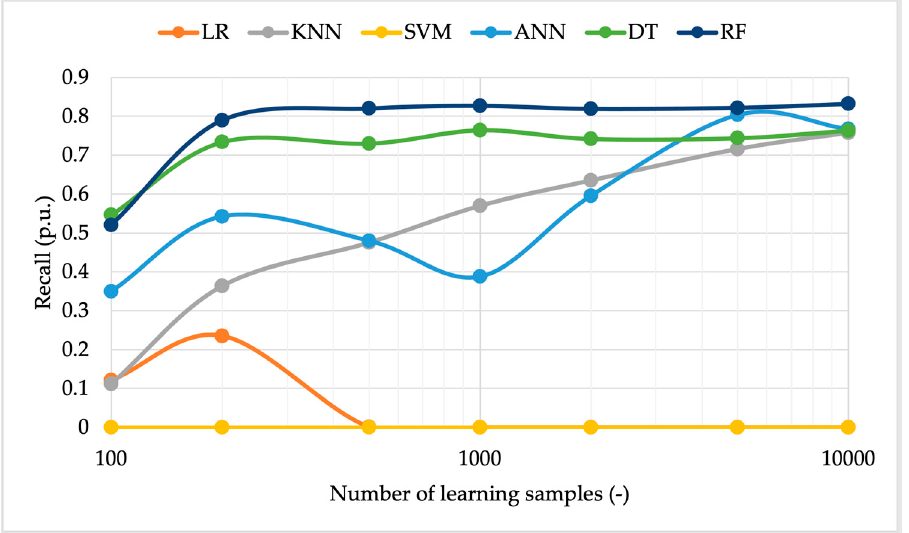
Figure 8. Algorithm recall vs. the number of learning samples using uniform distributed inputs.